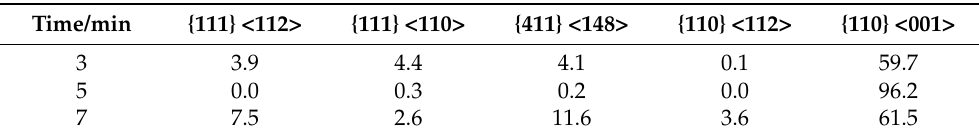
Table 3. Texture content after 850 ◦ C high-temperature annealing with different decarbonization annealing